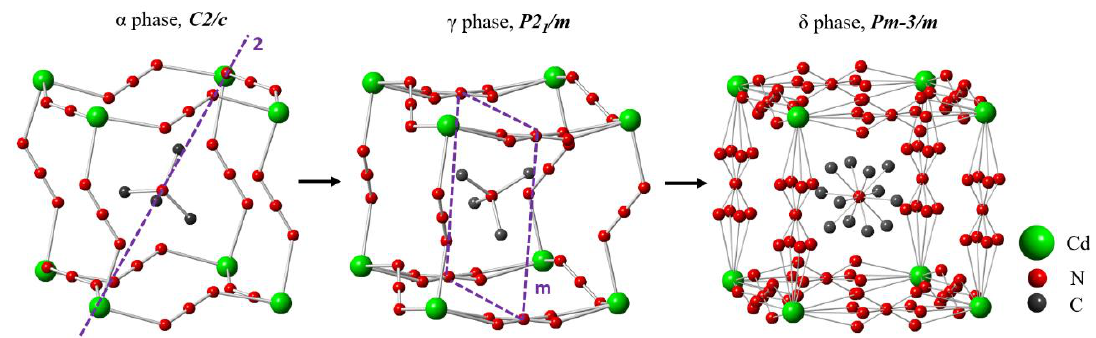
Figure 1. Perspective view of the crystal structures of the α , γ and δ phases of [(CH 3 ) 4 N][Cd(N 3 ) 3 ]. Cd, N and C atoms are shaded in green, red and dark gray, respectively.